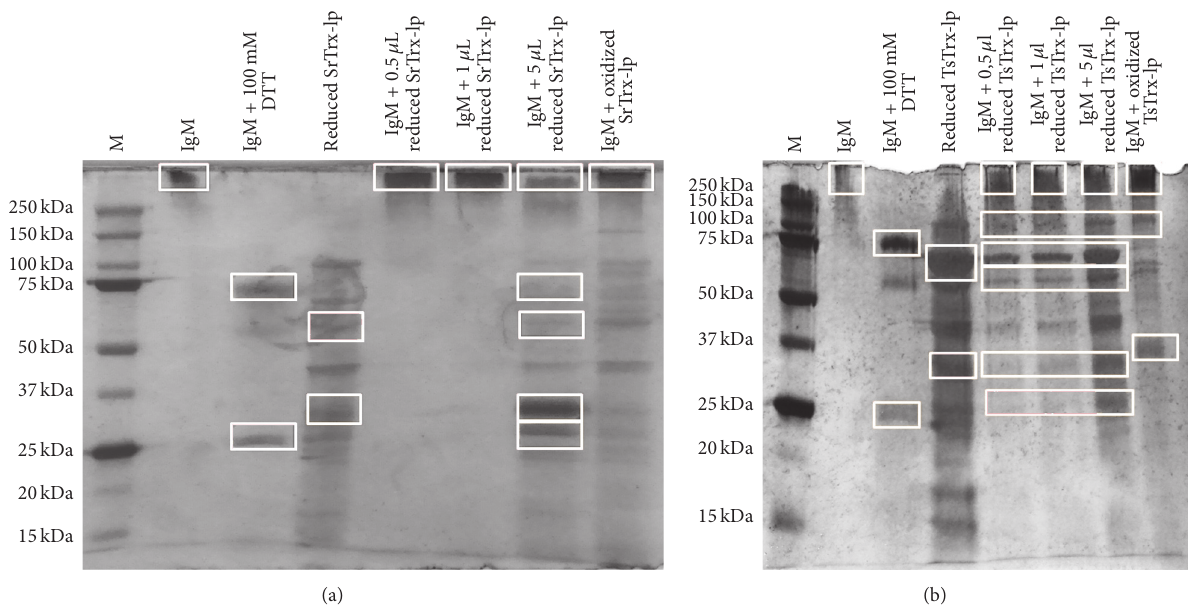
Figure 4: IgM reduction by the Trx-lps from S. ratti (a) and T. suis (b). Prior to incubation, the Trx-lps from both organisms were reduced by DTT. IgM was split in its chains (25kDa, 70 kDa, and 950